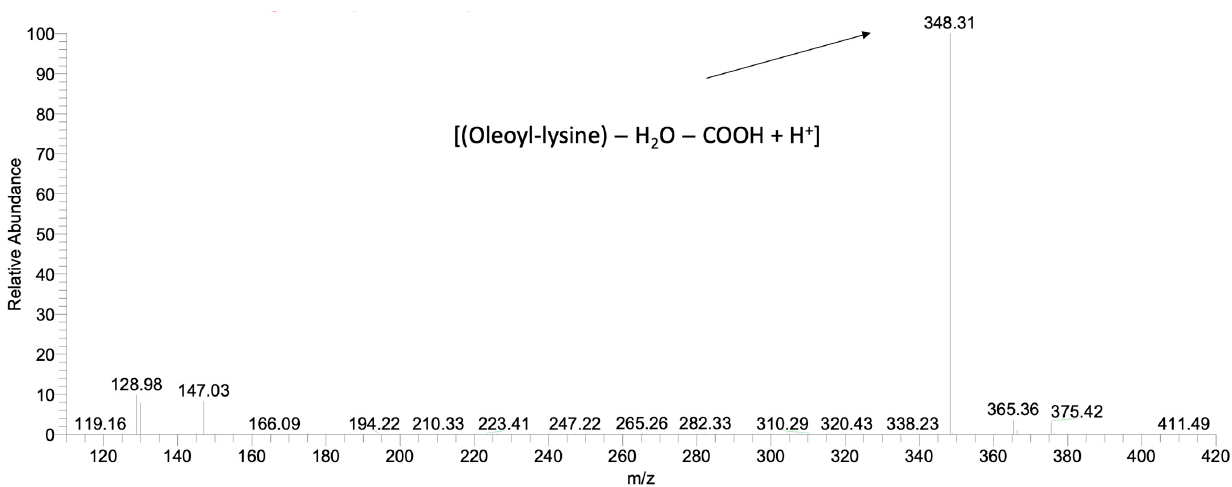
Figure 3. HPLC-MS2 spectrum after fragmentation of the ε -oleoyl-lysine parent ion ( m/z = 410) synthesised by CALB.